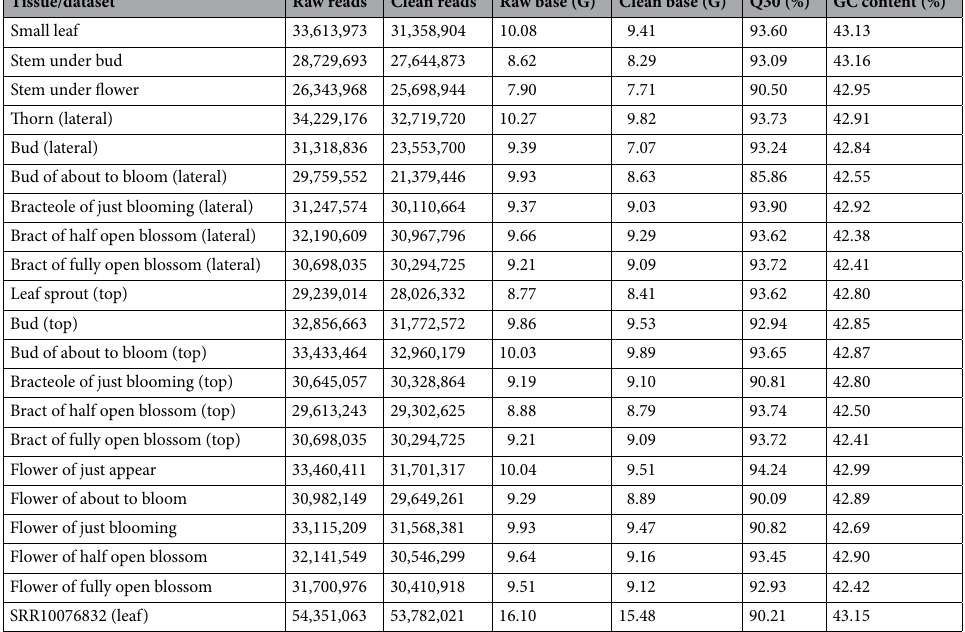
Table 1. Illumina RNA-sequencing datasets used in this